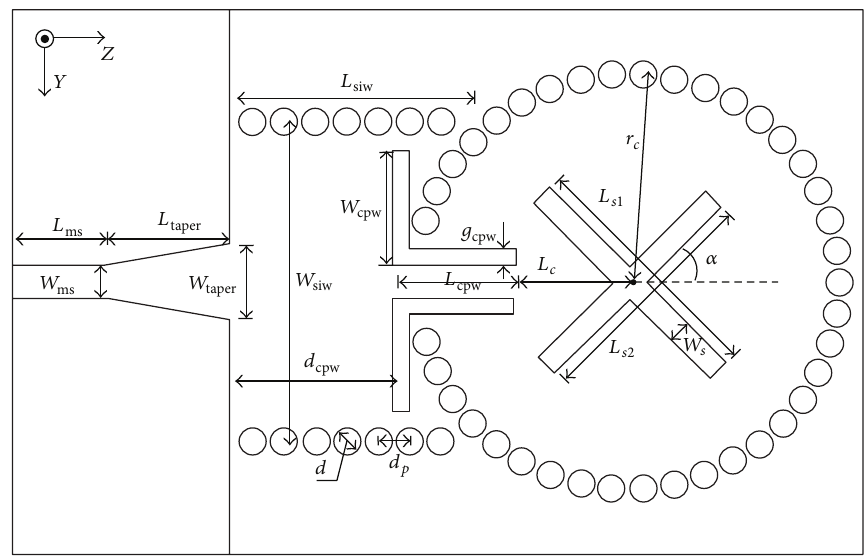
Figure 1: Geometry of the proposed antenna.